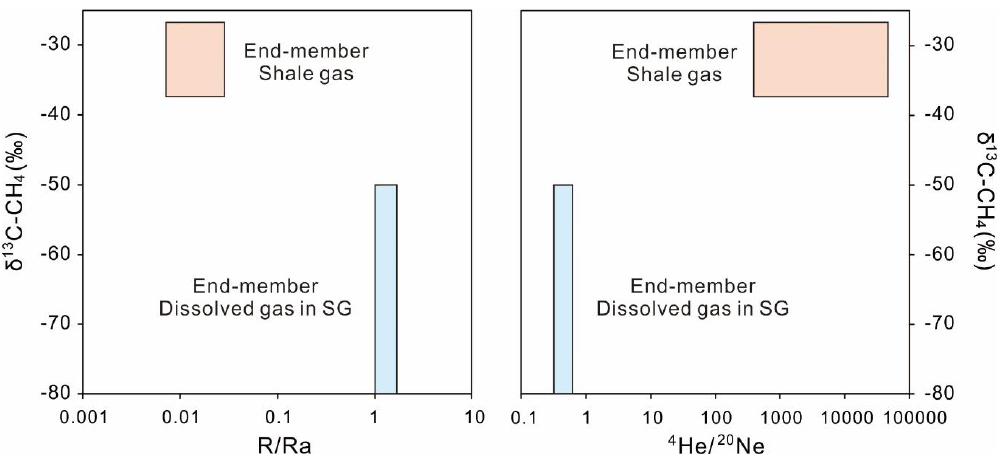
Figure 11. The plots of δ 13 C-CH 4 versus R/Ra, δ 13 C-CH 4 versus 4 He/ 20 Ne with dissolved gas and shale gas as two end-members. The red zone is restricted to the data of shale gas from three gas fields in Sichuan Basin [56,117] and Xishui, while the blue zone represents the range of dissolved gas in local shallow groundwater. If shale gas strays into the dissolved gas, the δ 13 C-CH 4 , R/Ra, and 4 He/ 20 Ne of contaminated groundwater may lie between two